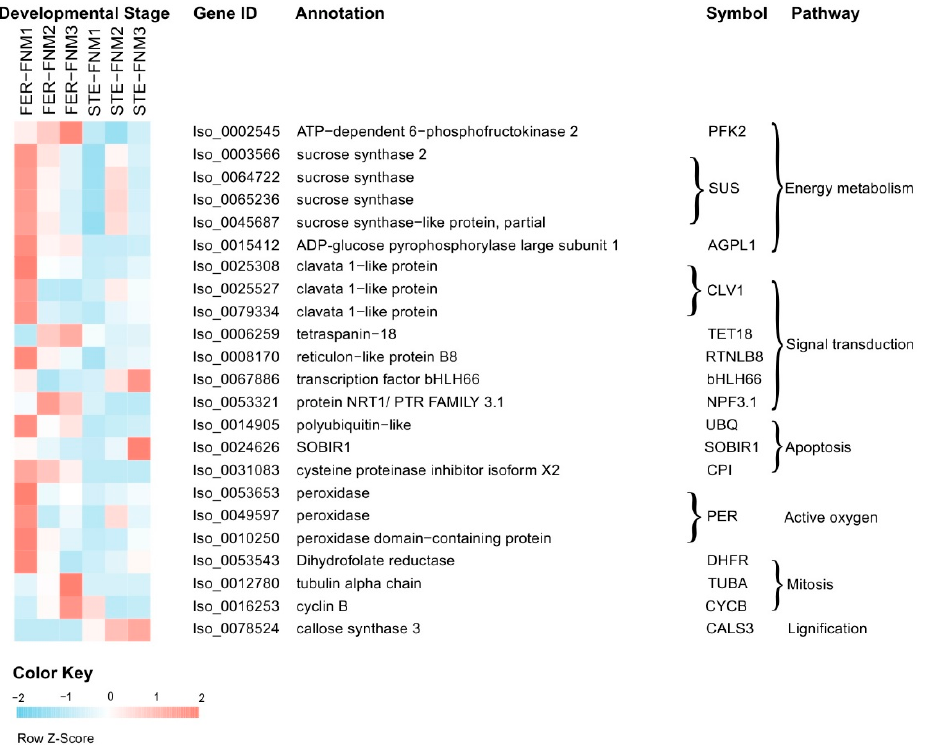
Figure 4. Heat map diagram of expression levels of DEGs, showing obvious differences in different lines. The gene expression level data were normalized to Z-score.